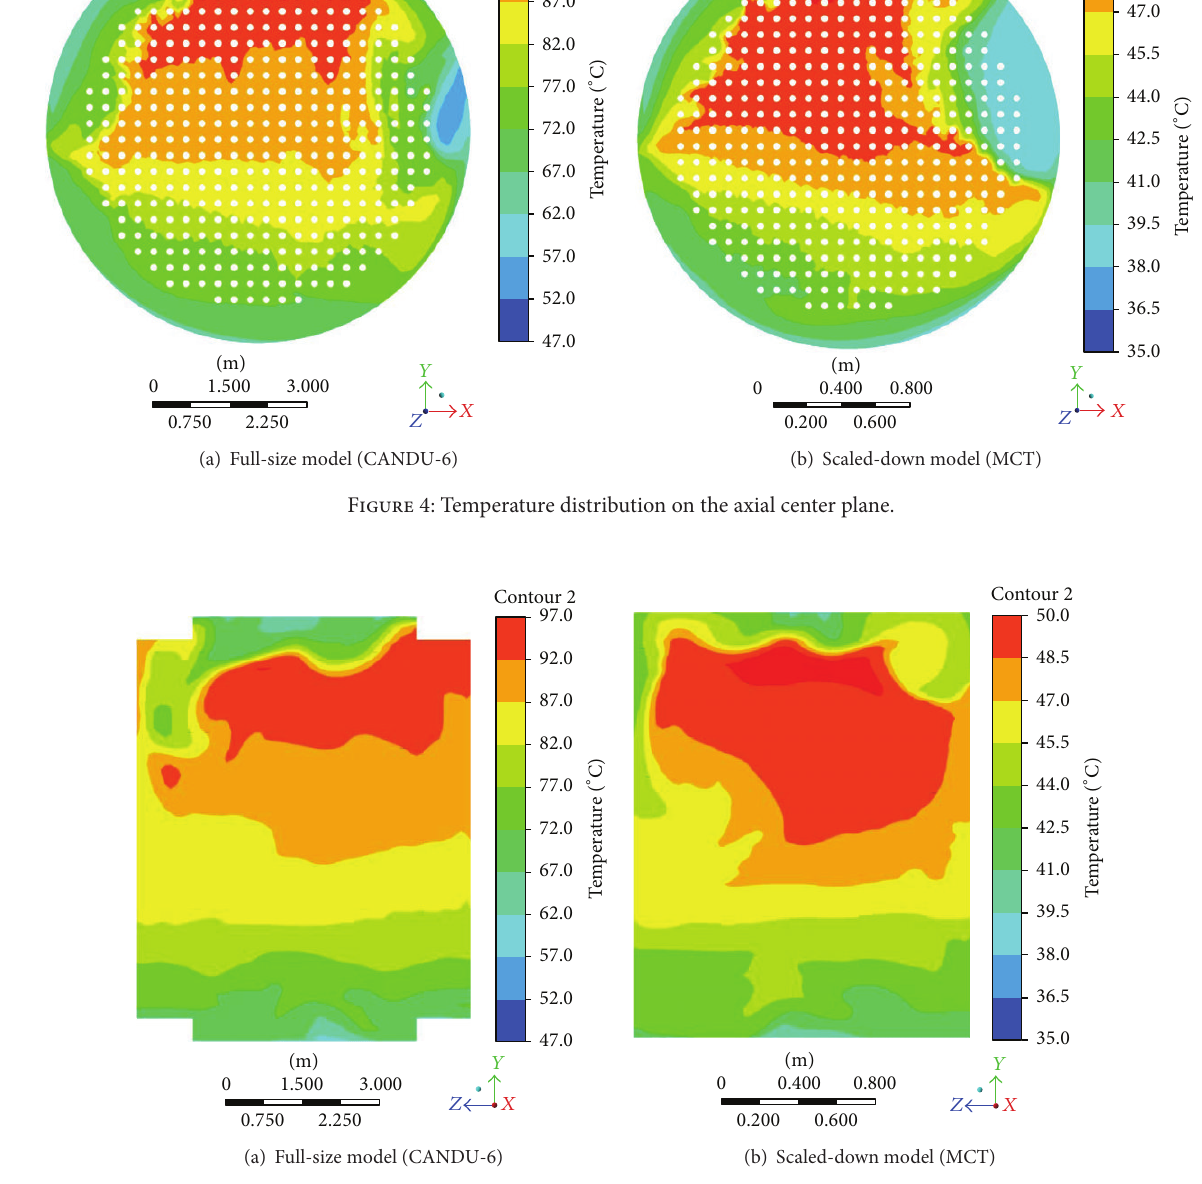
Figure 5: Temperature distribution along the axial